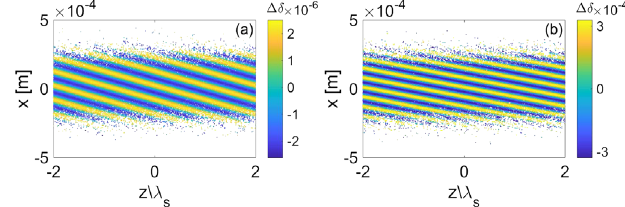
FIG. 4. For the case of laser incident in the z − x plane, distributions of the induced energy deviations after the obliquely incident laser-electron interaction with a 3D simulation program. The incident angles of the seed laser are 2.6 mrad (a) and 3.8 mrad (b),